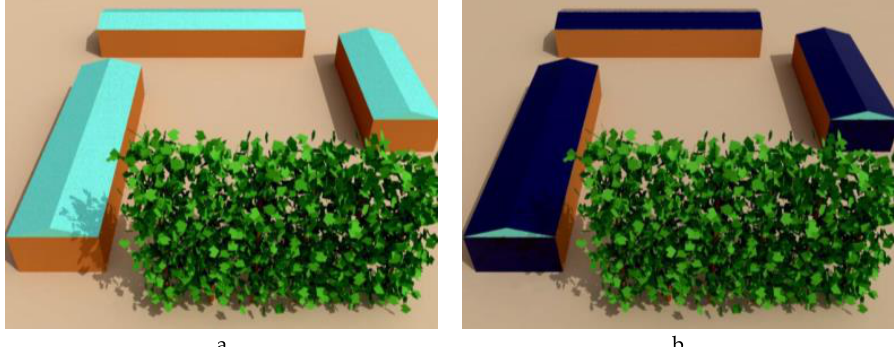
Figure 4. View of the ( a ) 3D model used to calculate PV production in the district and ( b ) areas that is possible to dedicate to PV highlighted. The model represents the three multi-family buildings that comprise the 48 households in the study. Please note that each household does not own any physical portion of the roof as it is commonly owned. If a household decides to invest in the shared PV system, it becomes shareholder of the common infrastructure (it does not purchase a physical small system on the roof).